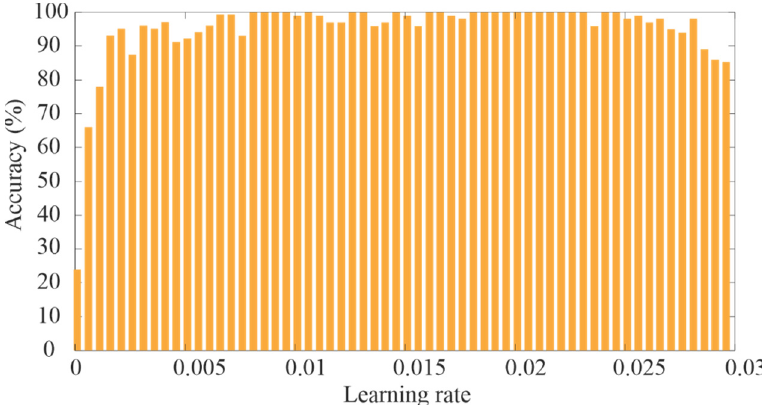
Figure 14. Obtained accuracy for different learning rate values.